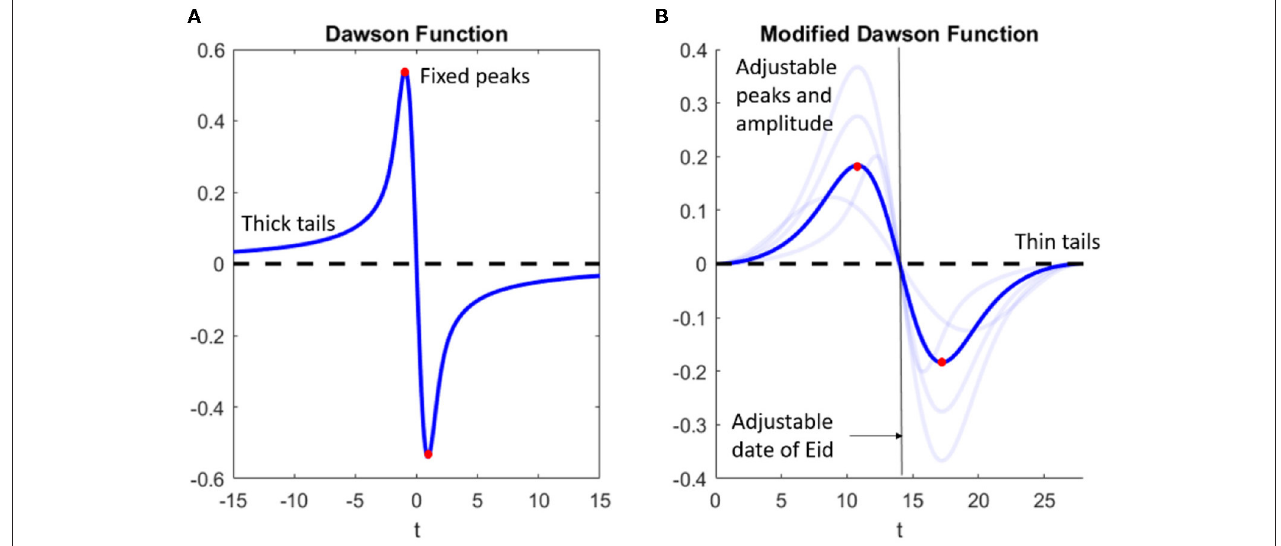
FIGURE 2 | Comparison of the generic Dawson Integral function (A) with its modification (B)